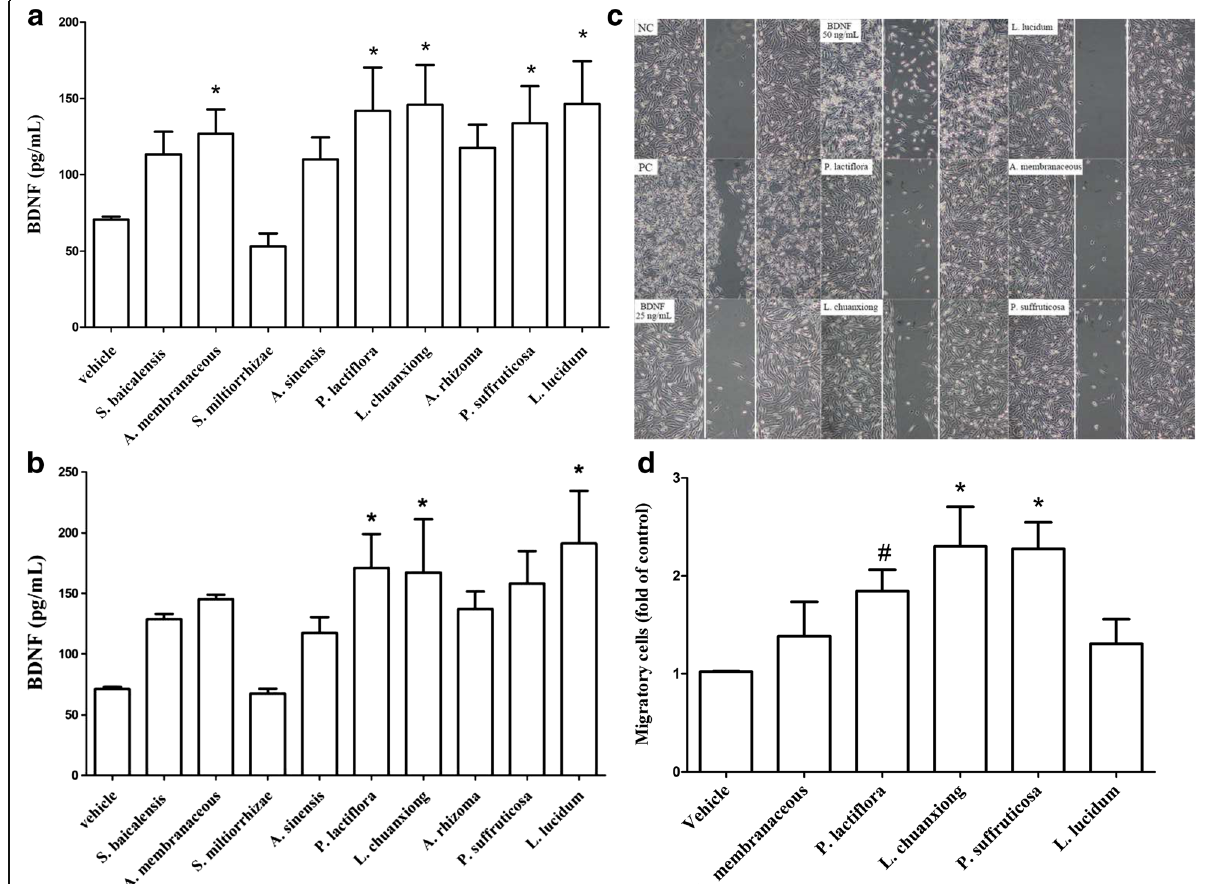
Fig. 3 Effects of the various Chinese herbal extracts (CHE) on BDNF secretion, cell migration and cell invasion using the MDA-MB-231 line. MDA- MB-231 (4 × 10 5 /well) cells were cultured with low serum medium and this was followed by administration of each of the various CHEs individually (1 μ g/mL for each herbal extract) for 24 h. Each culture medium was collected to allow the BDNF level ( a ) and BDNF level normalized against the cell number ( b ) to be measured by ELISA as described in Methods. CHE-induced cell migration ( c ) was evaluated by migration assay. Those herbs with migration-stimulating potential were also evaluated by invasion assay ( d ). The data are expressed as mean + SEM. *, p < 0.05 compared to vehicle group by repeatedly measured one way ANOVA (n = five independent experiments in each